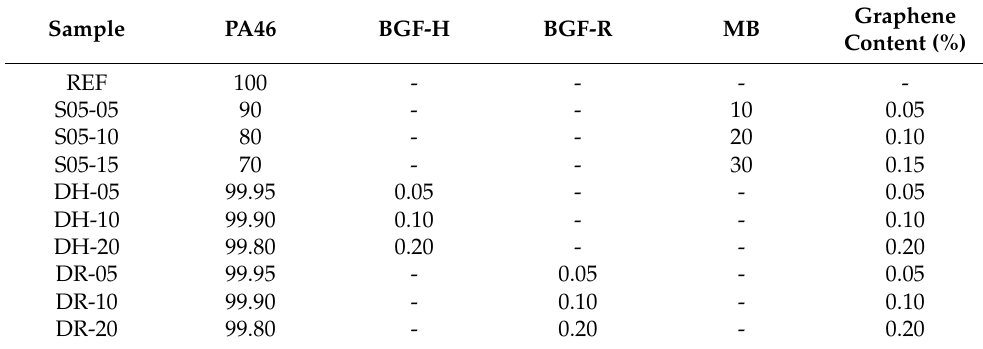
Table 1. Formulation of PA46/Graphene Nanocomposites.